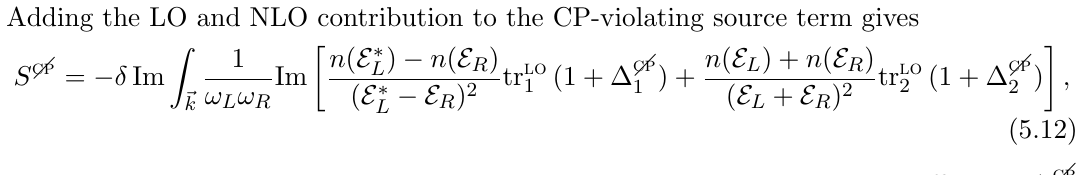
(cid:30) for quarks and leptons (cid:30) for quarks in the mass degenerate (cid:30) estimated by eq. (5.8). We take